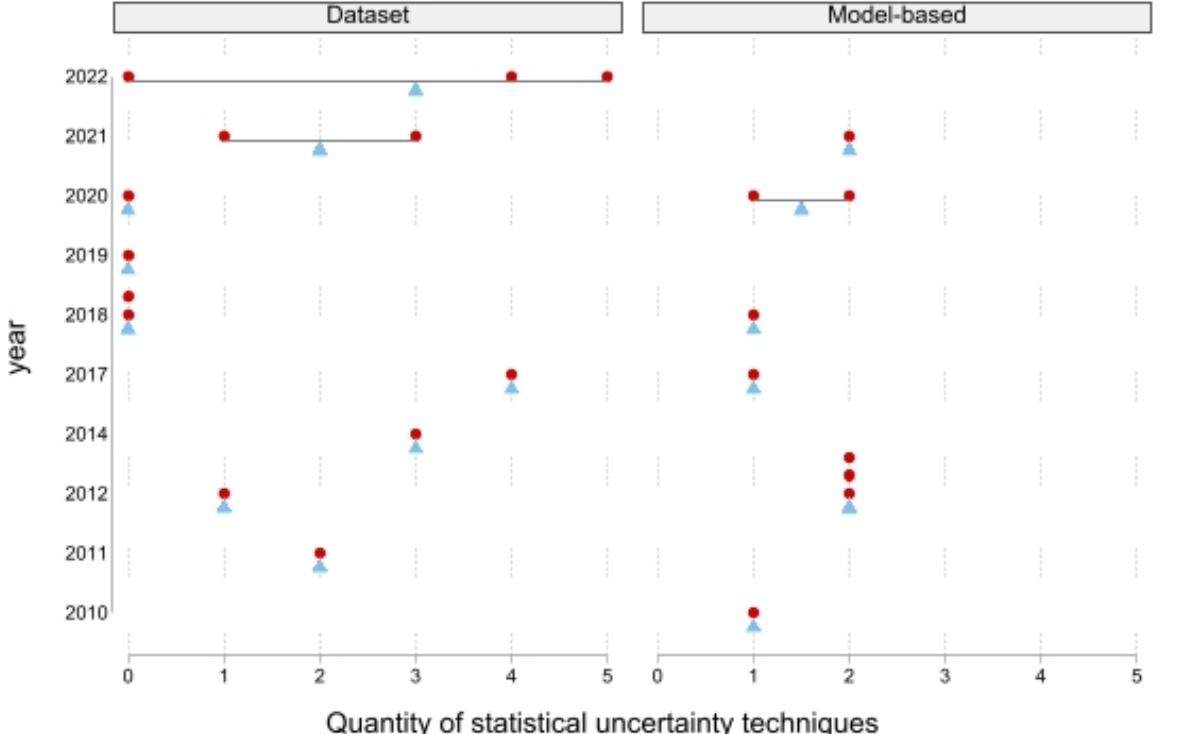
Figure 6. Quantity of statistical uncertainty techniques by year.